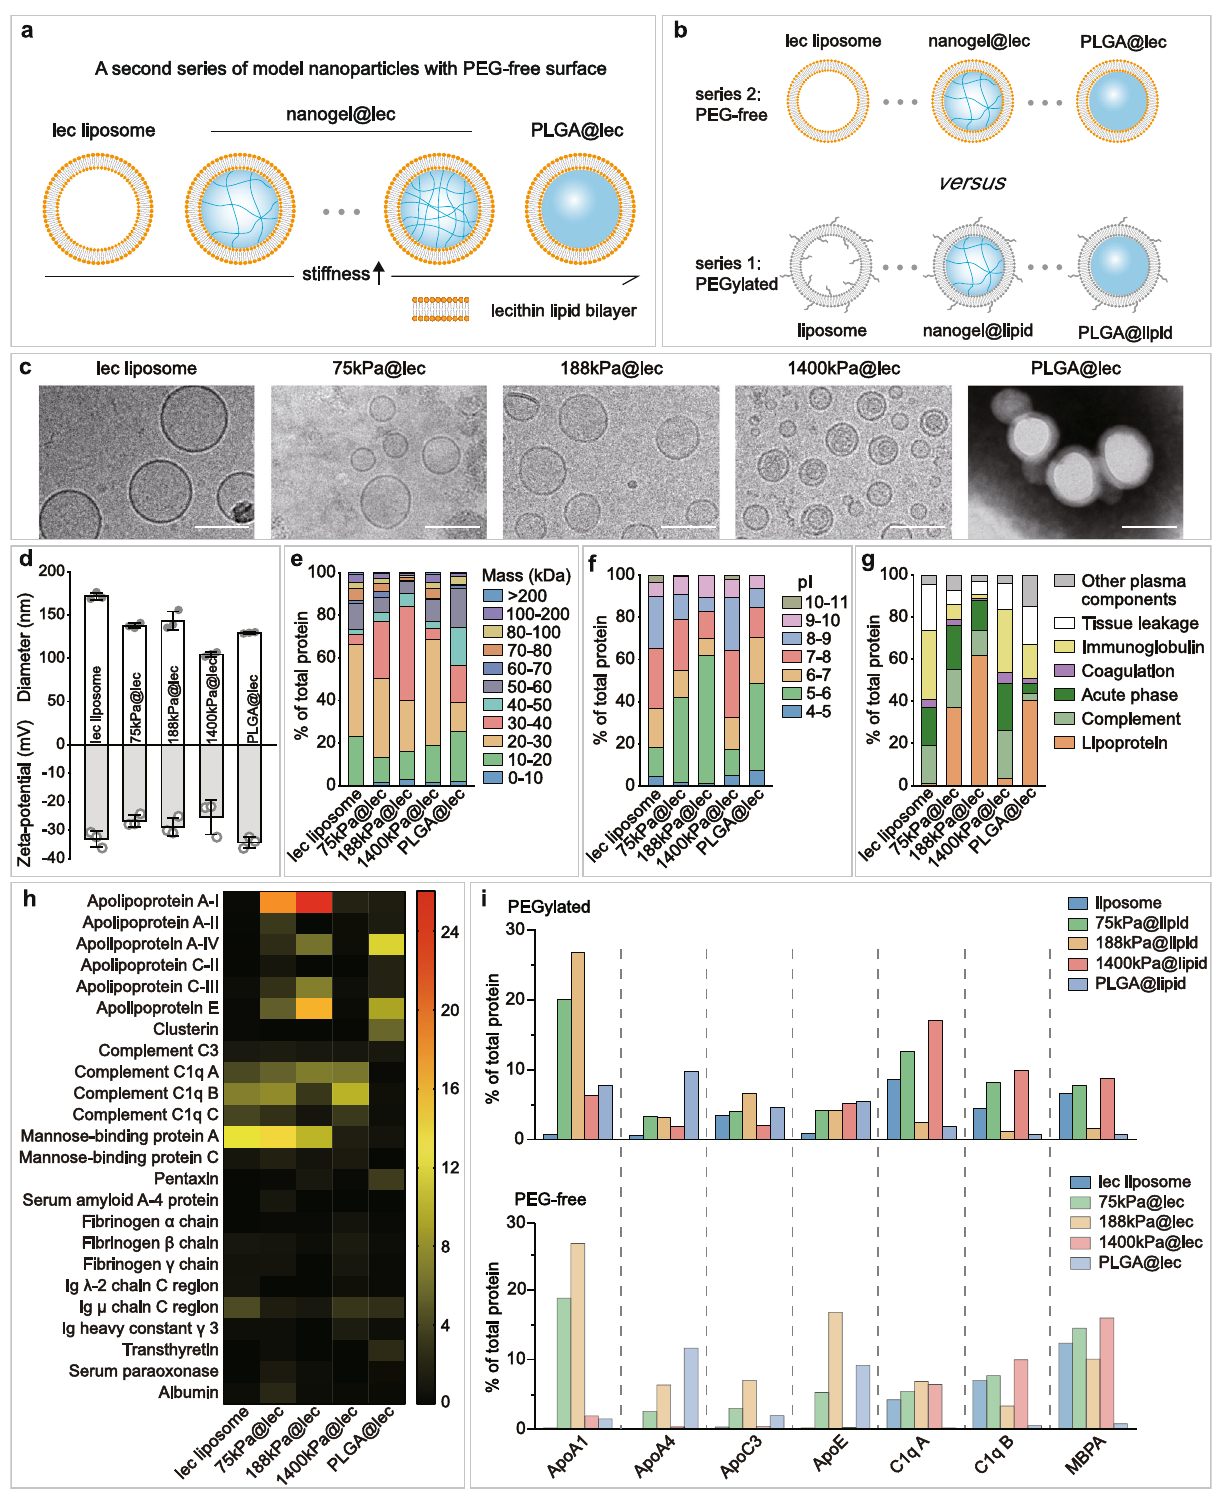
Preparation of liposome . DOPC stock solution (20 mg/mL, in chloroform) was mixed with DSPE-PEG 2000 stock solution (20 mg/mL, in chloroform) at a mass ratio of DOPC: DSPE-PEG 2000 = 90 : 10. The resulting mixtures were dried to a thin fi lm under gentle stream of N 2 , and desiccated under vacuum overnight. The resulting thin fi lm was rehydrated with Millipore water at 40 °C for 2h to a fi nal lipid concentration of 10 mg/mL. The resulting lipid dispersion were subjected to seven freeze − thaw cycles and then extruded through nucleopore membrane with pore size of 0.2 μ m (Whatman) for 13 times using a mini-extruder (Avanti Polar